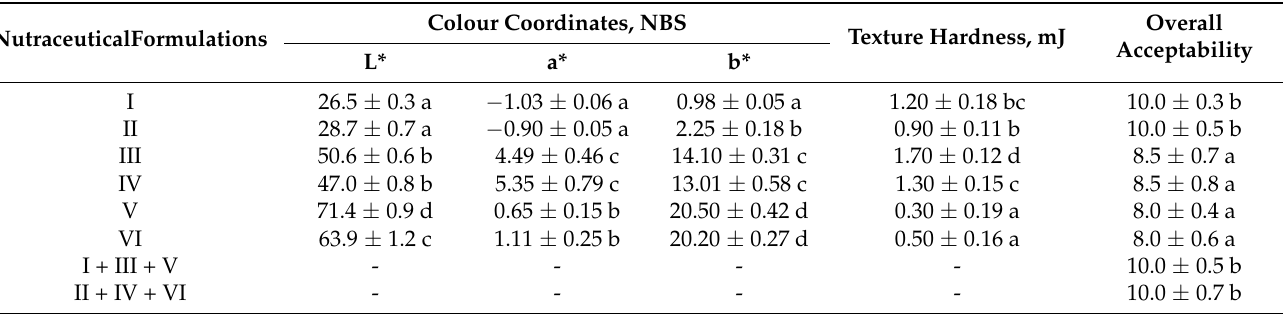
Table 3. Colour coordinates and texture hardnesses of the separate nutraceutical layers and overall acceptability of the separate layers and final